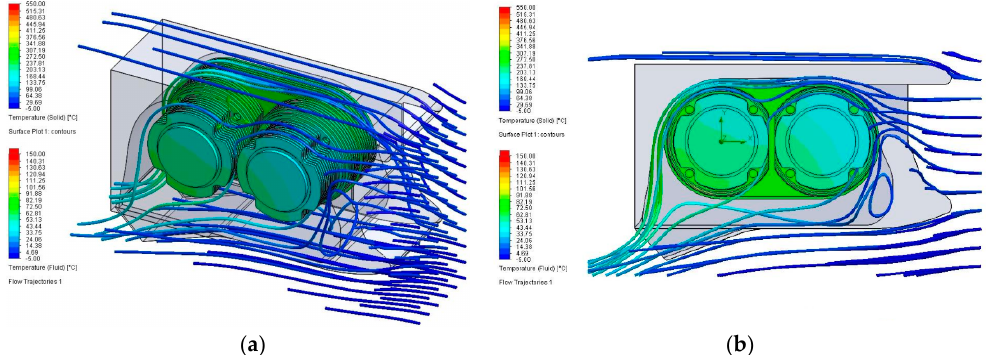
Figure 7. Simulation result from initial temperature of 240 °C at 100 kt: ( a ) Isometric view ( b ) Side